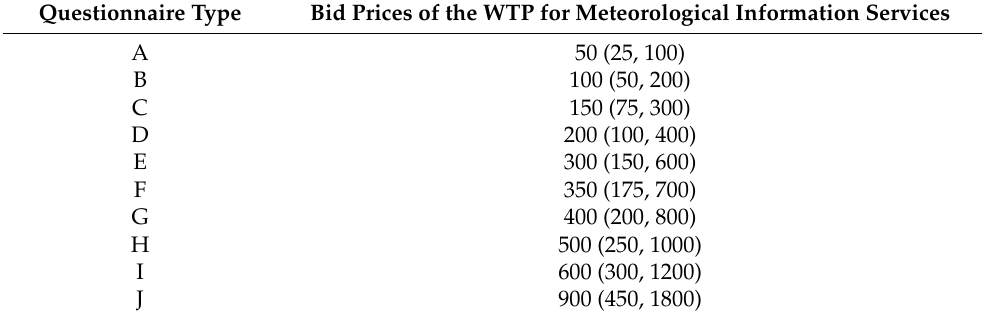
Table 2. Pre-survey questions to determine